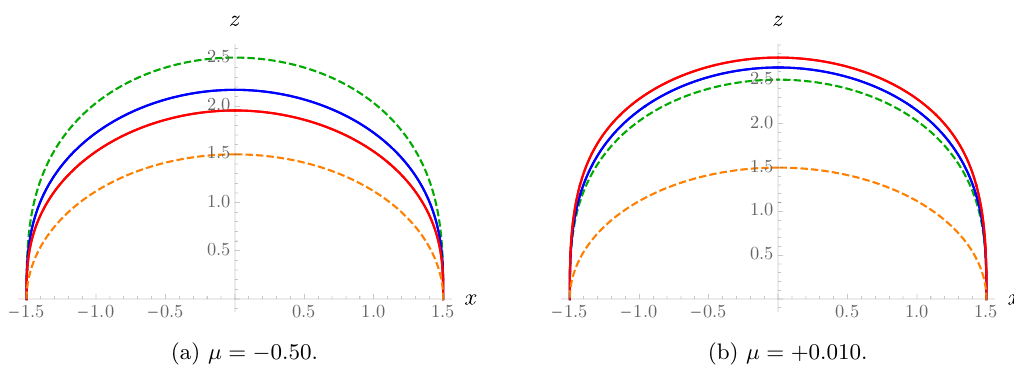
Figure 1 . Causal wedge (orange, dashed) and entanglement surfaces corresponding to ECG in the case of minimal prescription (blue), ECG in the case of non-minimal prescription (red), and Einstein gravity (green, dashed) [35] for the boundary strip length ‘ = 3 and two different values of µ outside the interval − 0 . 00322 ≤ µ ≤ 0 . 00312 . In both cases, we verify that causal wedge inclusion is satisfied for both